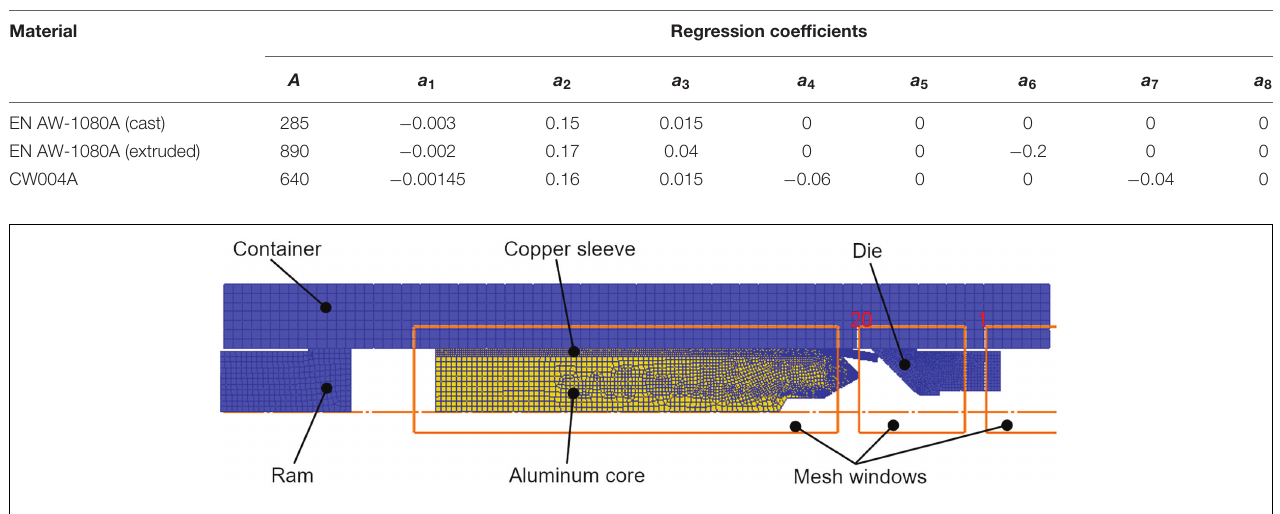
FIGURE 7 | FE-model for the indirect extrusion of the copper-clad aluminum rod. TABLE 2 | Friction parameters and heat transfer coefficients for the FE-analysis of the indirect extrusion. Contact surface Al-Cu Al-Die